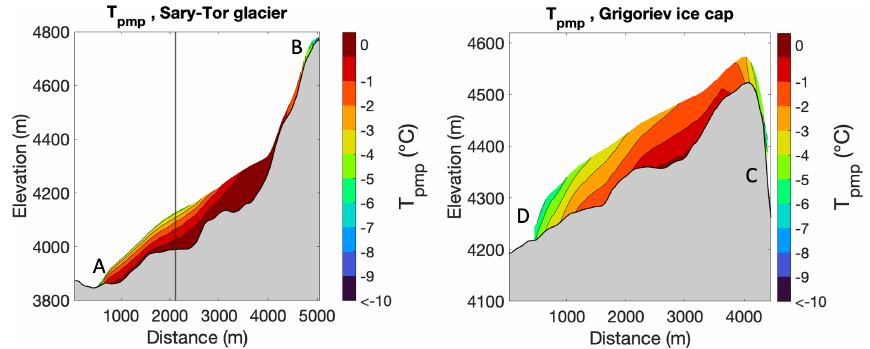
Figure 9. Modelled ice temperatures of the Sary-Tor glacier and the Grigoriev ice cap along the central flowline using a freely evolving geometry and corrected for the pressure melting point. The vertical line in the plot of the Sary-Tor glacier corresponds to the cross-section used in Fig.